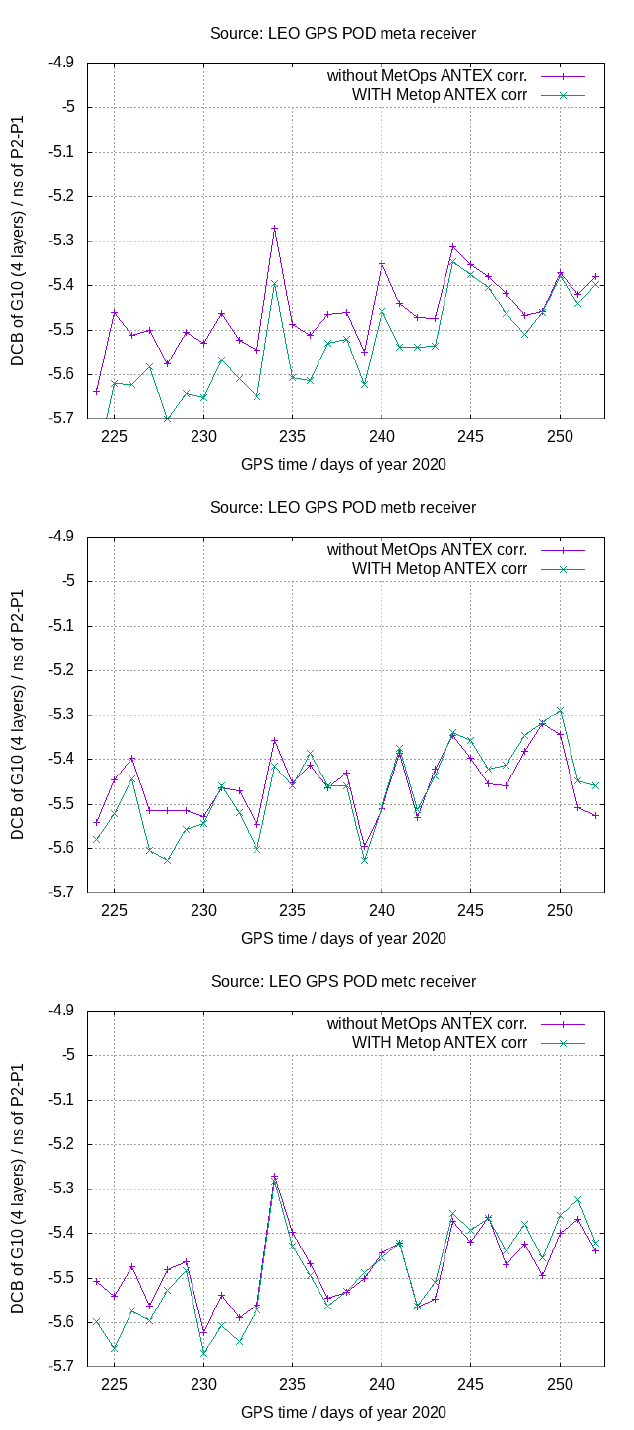
Figure 7. Comparison of the daily GPS10 transmitter DCBs estimated from MetOp zenith measure- ments only without (magenta) and with (green) receiving antenna corrections, two layers above LEOs and since days 224 to 252 of year 2020, from meta ( top ), metb ( center ) and metc ( bottom )